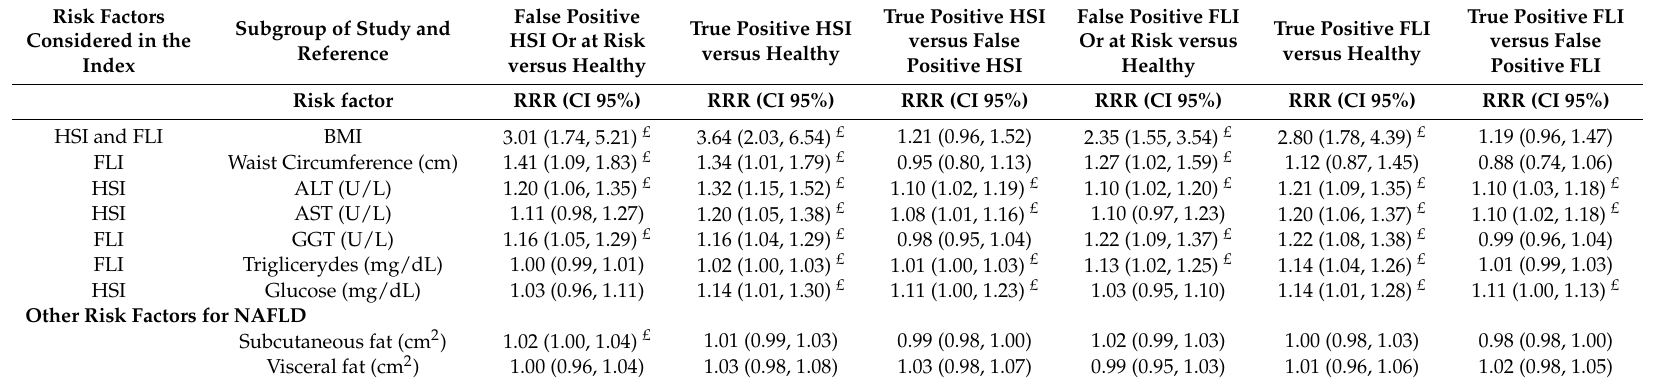
Table 2. Association between metabolic risk factors for healthy subjects, and those with NAFLD, HSI, and FLI ( n = 100).